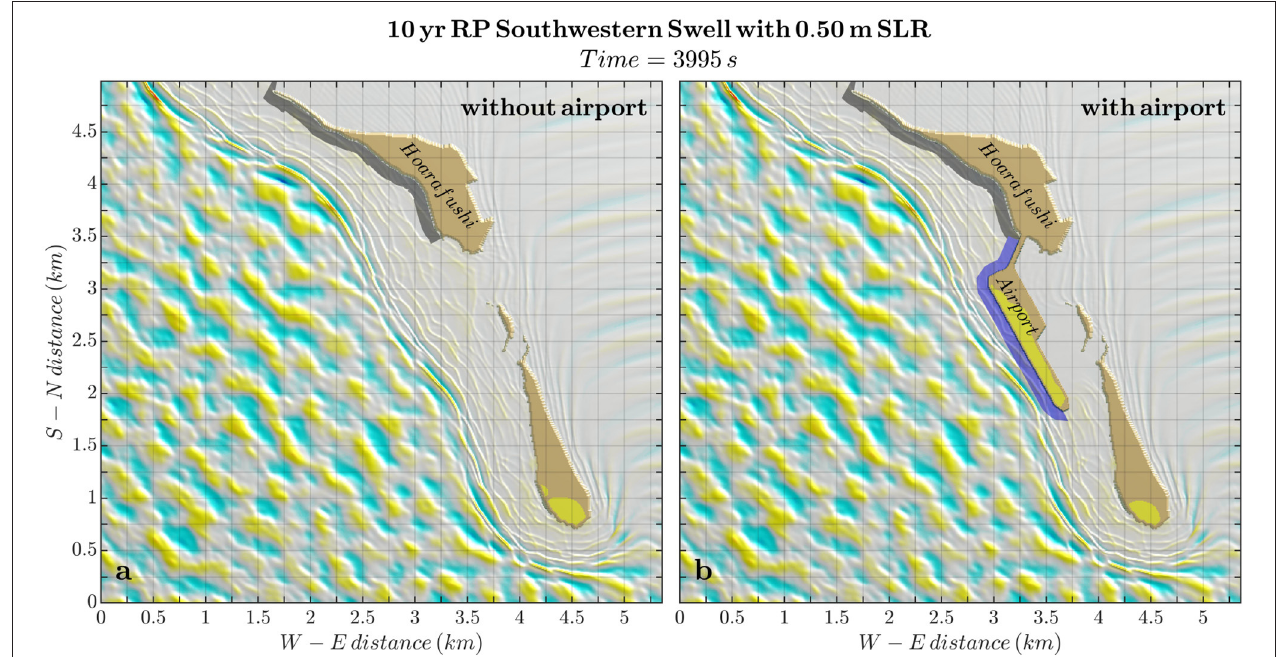
FIGURE 8 | Example of local downscaling simulations with SWASH model (see section 2.3 for details) for the 10 year return period southwestern swell event with 0.5 m of sea level rise (this increase in sea level could mean permanent sea level or high tide with present sea level) for the case without the airport (a) and with the new airport (b) . Grey (purple) stripe indicates the coastal region where the box plots from Figure 9 ( Supplementary Figure 15 ) are computed.